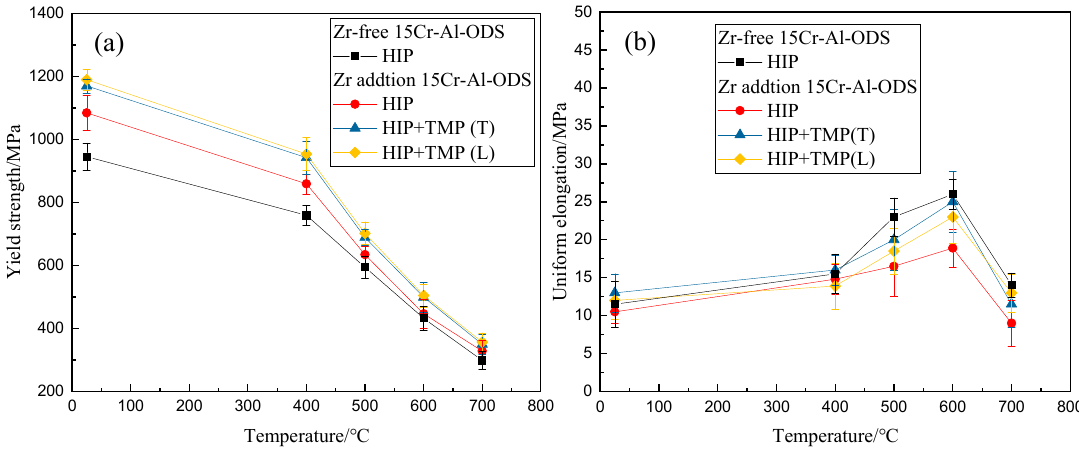
Figure 7. Tensile properties of Zr-free and Zr addition 15Cr-Al-ODS from RT (room temperature) to 700 °C ( a ) yield strength and ( b ) total elongation.